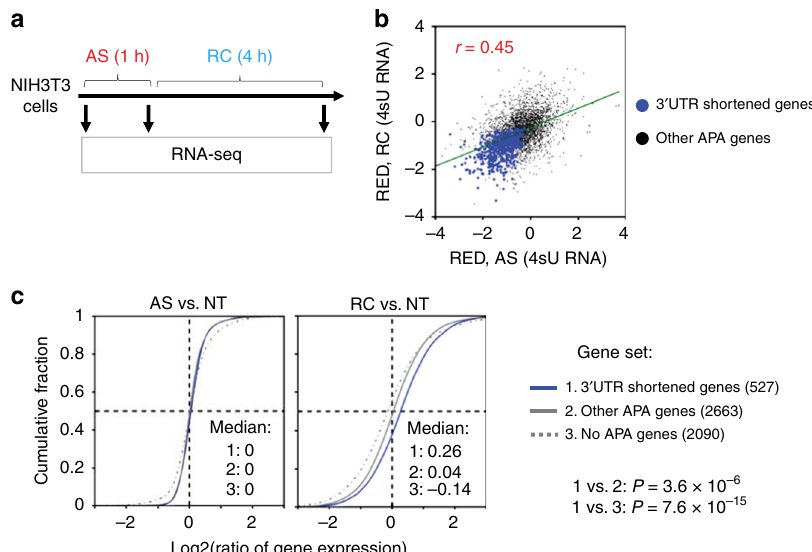
Fig. 5 3 ′ UTR shortening by APA leads to preservation of mRNA during stress recovery. a Schematic of experimental design. Total cellular RNA was subject to strand-speci fi c RNA-seq to examine gene expression changes. Only reads mapped to CDS were used, which avoided the in fl uence of 3 ′ UTR size change on gene expression analysis. b Identi fi cation of genes with shortened 3 ′ UTRs through APA. Genes with signi fi cant 3 ′ UTR shortening in newly made RNAs of both AS and RC samples (shown in blue) were selected. Black dots are other genes with APA isoforms detected in NIH3T3 cells. c RNA abundance changes for three groups of genes after AS (1 h, left) or RC (4 h, right). Groups 1 and 2 genes correspond to blue and black dots in b . Group 3 genes were those without APA isoform expression in NIH3T3 cells. Gene numbers are shown in parentheses. Median log2(ratio) of gene expression level (RPM) between two conditions is shown in each graph. P -values (K – S test) indicating difference in gene expression change (RC vs. NT) between gene groups are